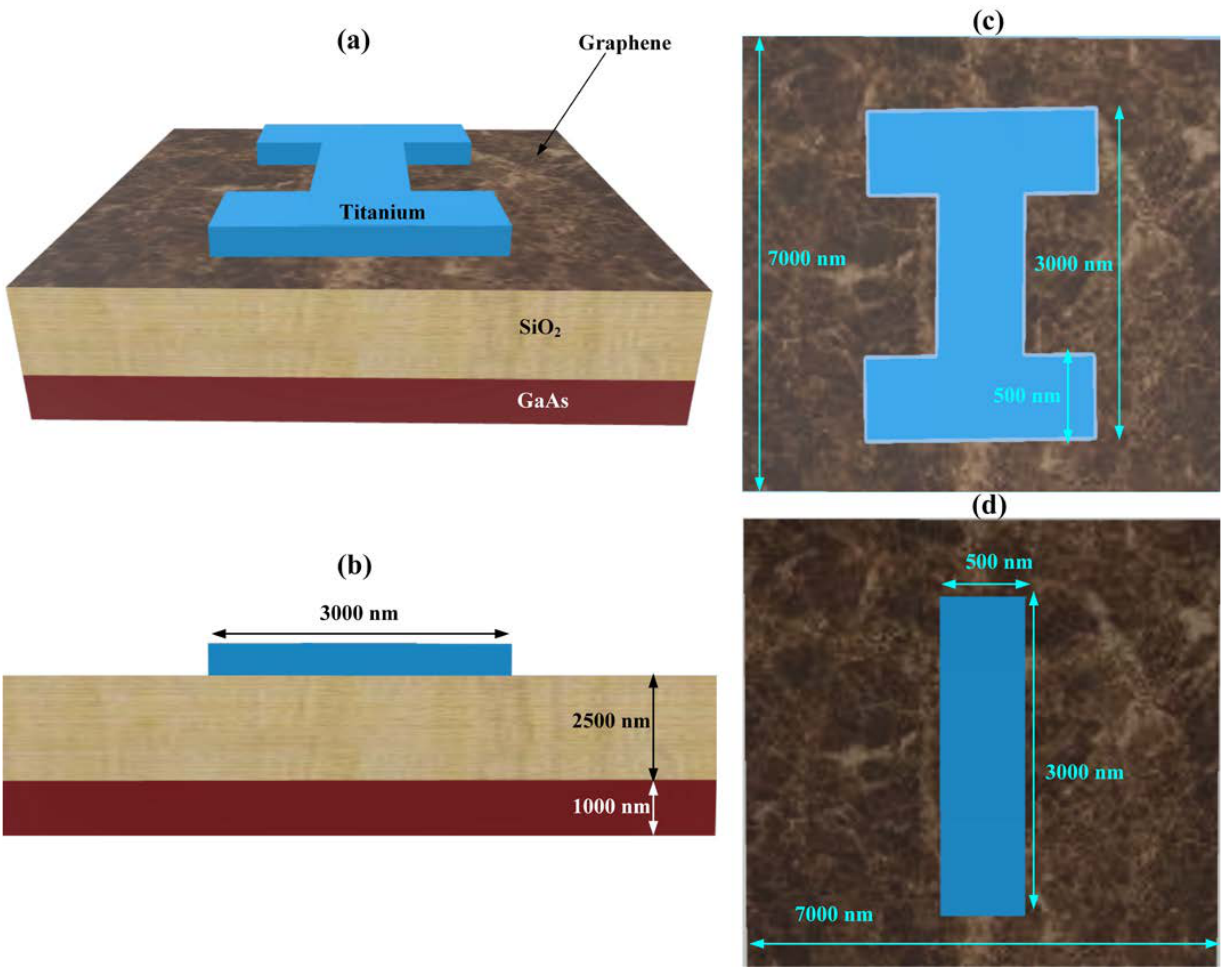
Figure 1. Structural design of the I-shaped and thin wire metasurface solar absorber. ( a ) an I-shaped solar absorber 3D view; ( b ) an I-shaped metasurface solar absorber front view; ( c ) an I-shaped metasurface solar absorber top view; ( d ) a thin wire metasurface solar absorber top view. The size of different parameters is presented in the figure. The length, width, and height of the substrate are 7000 nm, 7000 nm, and 2500 nm, respectively. The I shape and thin wire length are 3000 nm. The total length and width of an I-shape are both 3000 nm. A thin wire has dimensions of 3000 nm in length and 500 nm in width. The figure is not up to the scale. The three-layer design with sandwiching graphene layers is visible in the